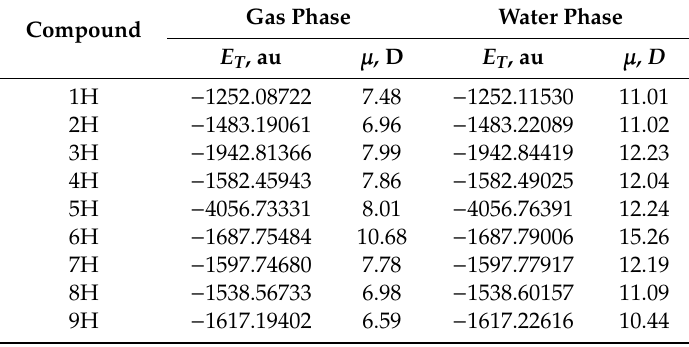
Table 3. Total electronic energy au, and dipole moment D, of the TUDHIPP derivatives 1H–9H